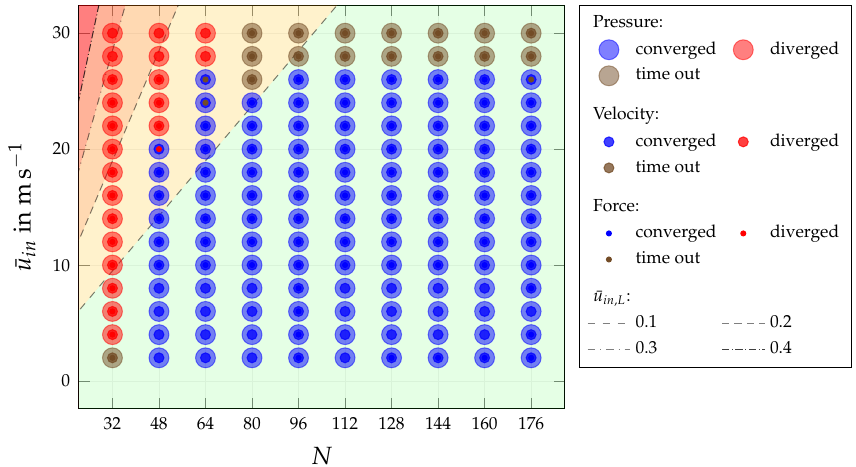
Figure 11. Stability map for pressure, velocity and force convergence in flow with single layer fragment. Contour lines show stability-relevant velocities at lattice scale. Background colouring indicates distance to theoretic LBM stability limit (green to